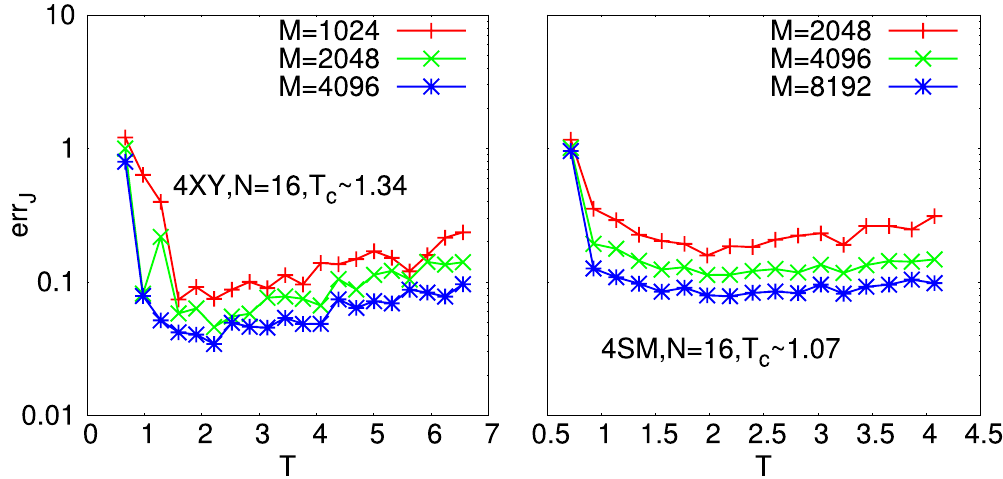
Figure 6. Reconstruction error at its minimum x min = x true in the decimation procedure vs. T for various M for N = 16 variables systems with bimodal random values of the coupling constants. Left: 4 XY model on sparse Erdos-Renyi graph with N = 16, N q = 16. Right: 4SM model on dense Mode-Locked graph with N = 16, N q =